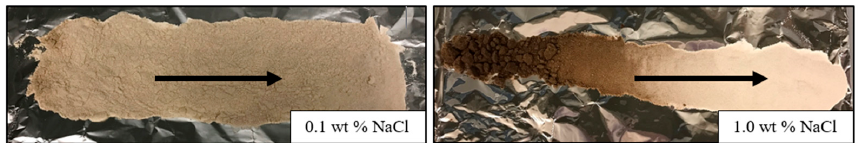
Figure 14. Evidence of nanocellulose retention from post-flood sand baking. Darkness correlates with mass of nanocellulose retained in sand after post flush. Arrows indicate flow direction in original sandpack. ( Left ) 0.5 wt. % CNC (USDA) in 0.1 wt. % NaCl at 66 ft/day resulted in uniformly distributed retention. ( Right ) 0.5 wt. % CNC (USDA) in 1.0 wt. % NaCl at 66 ft/day resulted in large retention near inlet decreasing to little or no retention in the downstream half of the sandpack. Both using 50–70 mesh sand.